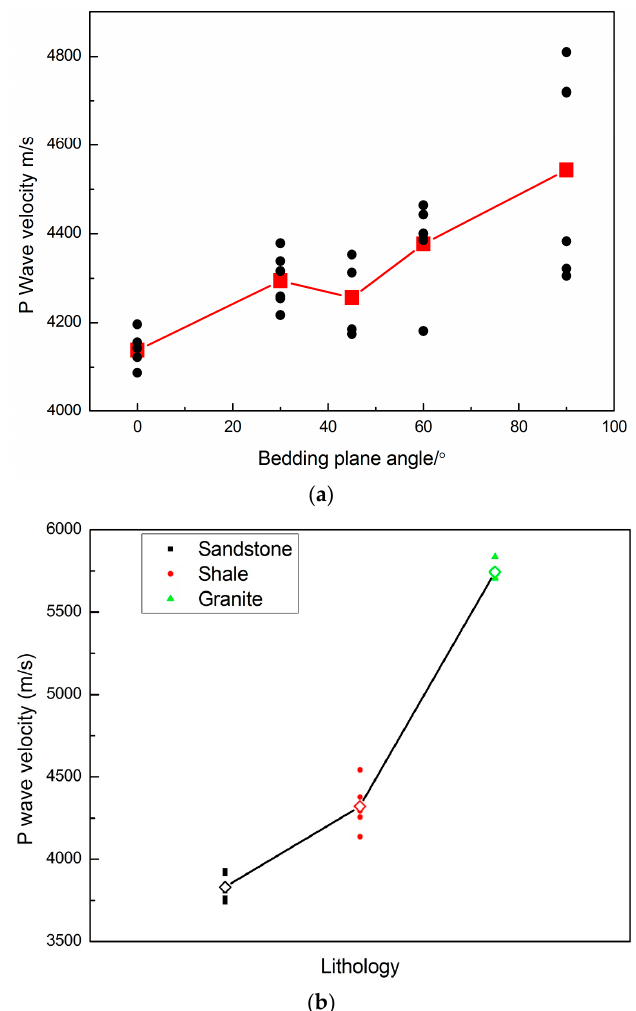
Figure 3. ( a ) The P wave velocity of each shale specimen was measured in the vertical direction. Note that the velocities of shale cores were measured with five bedding plane angles (0°, 30°, 45°, 60°, 90°) for the investigation of anisotropy result from sedimentary structure; ( b ) Comparison of P wave velocities of sandstone, shale, and granite cores.